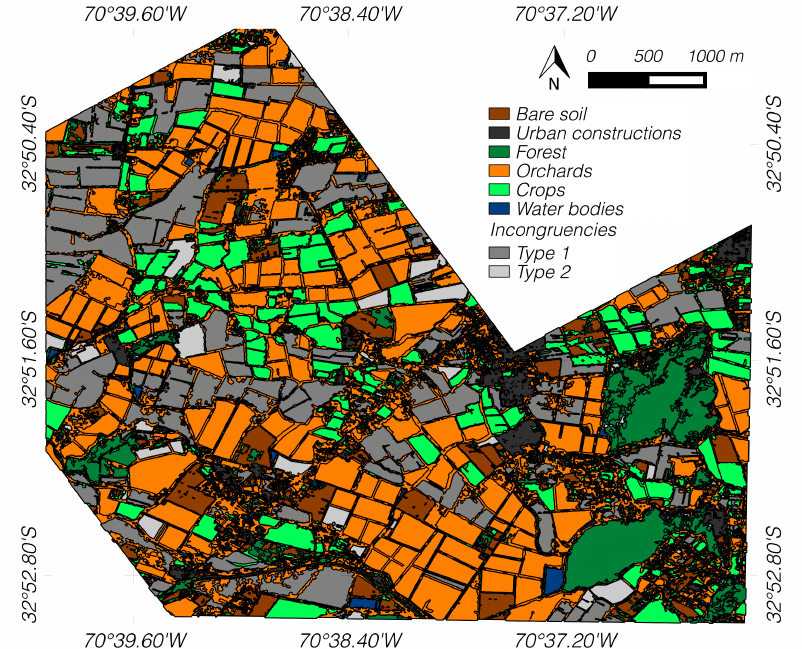
Figure 8. Combination of superpixel and parcel maps. In two different gray-levels, incongruent regions between parcel and superpixel maps are